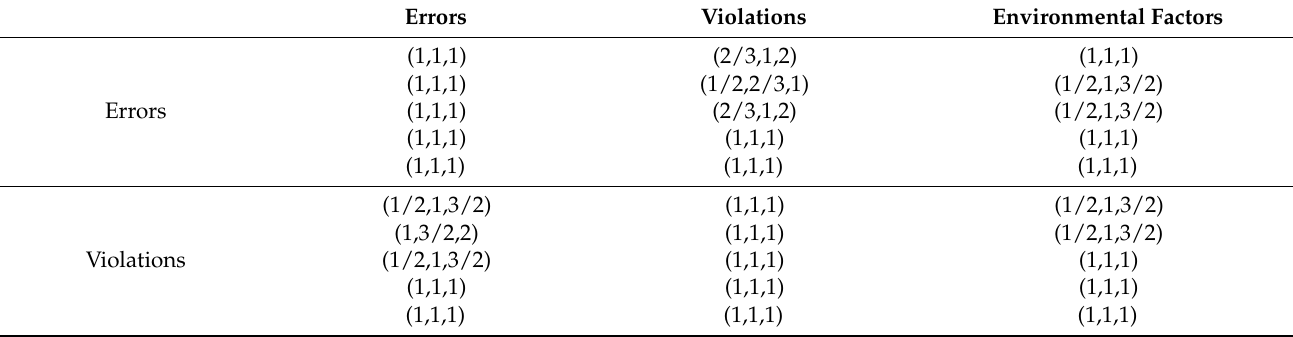
Table A1. Pairwise comparison of the elements in level 2 of the direct causes that lead to the accident. Errors